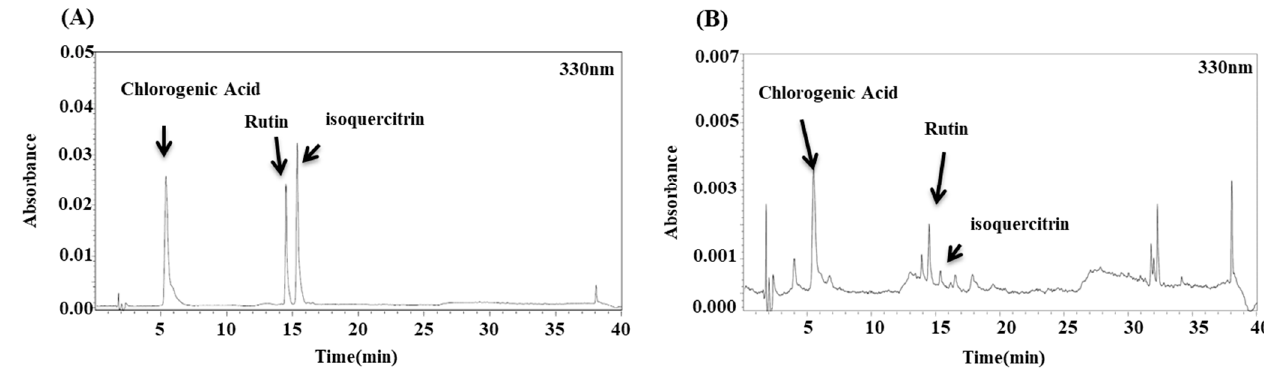
Figure 3. Picture of Ilex x wandoensis C. F. Miller and M. Kim Hybrid nov and scheme of IW extraction.